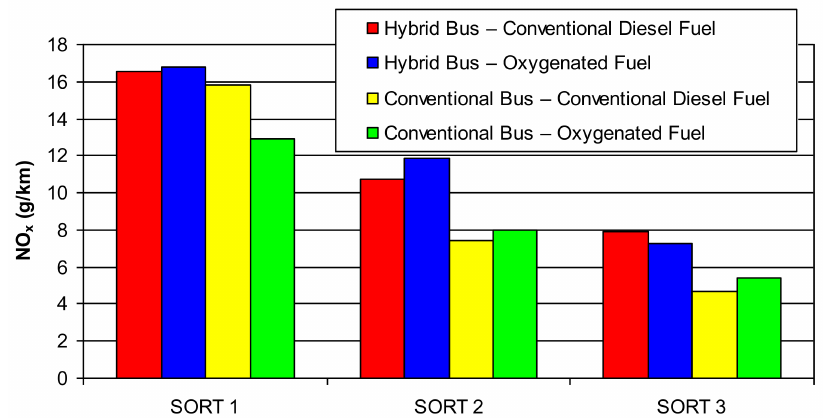
Figure 12. Comparison of NO x emissions of serial hybrid and conventional city buses running on conventional and oxygenated diesel fuel, over the SORT cycles.